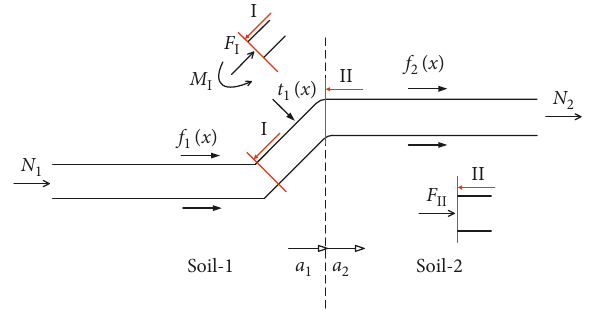
Figure 13: Mechanical model of pipe by TGD during 0.6g earthquake at 12s.